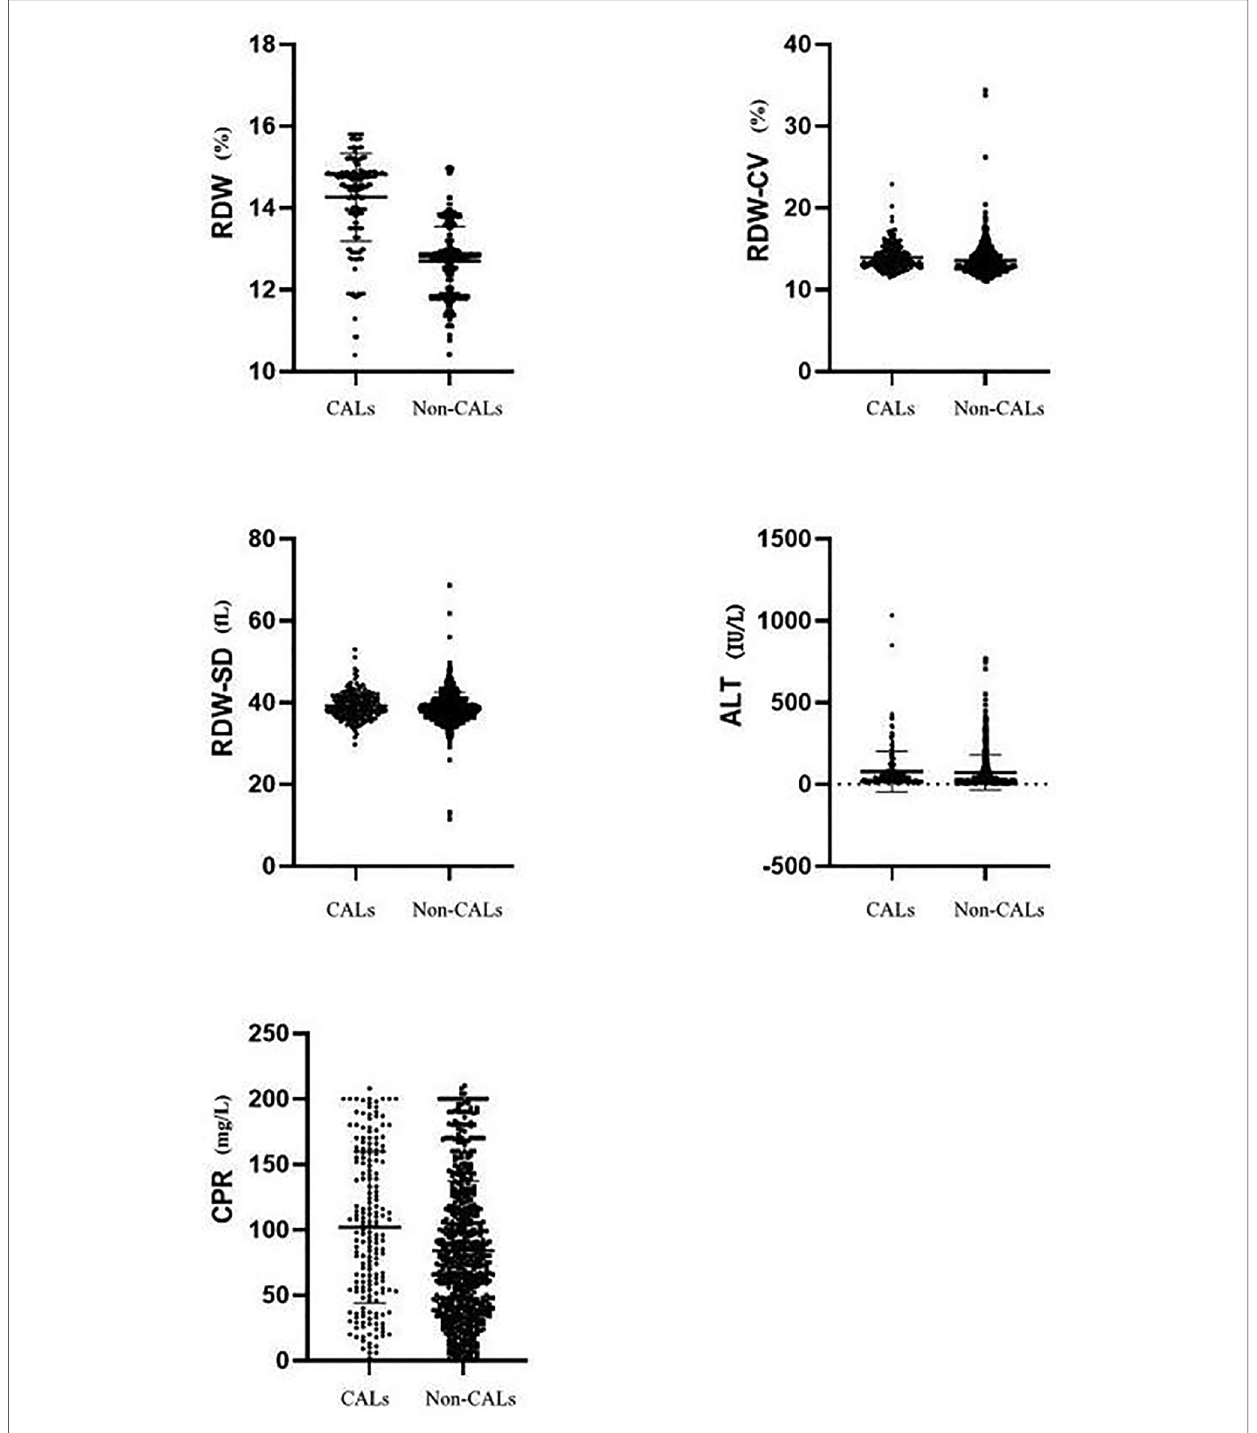
FIGURE 1 Comparison of RDW, RDW-CV, RDW-SD, ALT, and CRP between CALs group and non-CALs